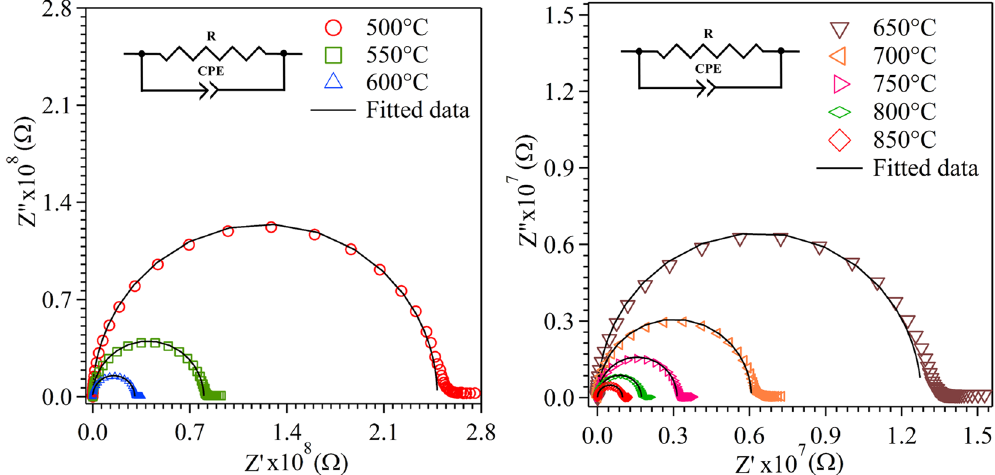
Figure 11. Nyquist plot measured at the temperature range from 500 to 850 °C for the thin film deposited at 100 °C substrate